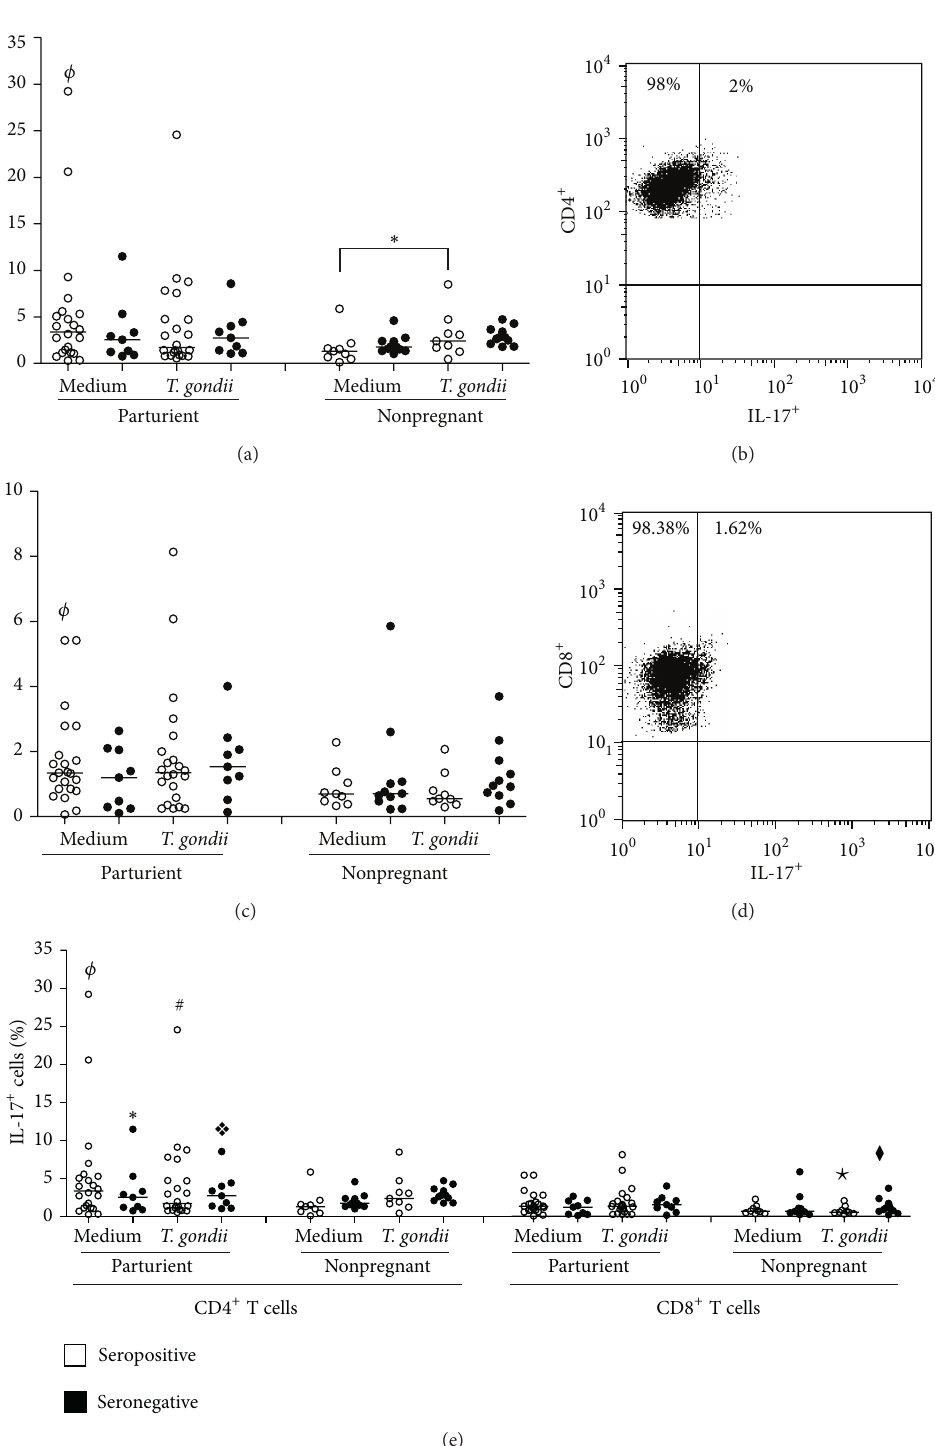
Figure 2: IL-17 + CD4 + T cells and IL-17 + CD8 + T cells from nonpregnant or parturient women. The horizontal line indicates the median, open circles indicate the T. gondii seronegative subjects, and filled circle indicate seropositive subjects. (a) The percentage of CD4 + T cells expressing IL-17. (c) The percentage of CD8 + T cells expressing IL-17. (e) Comparison CD4 + T cells and CD8 + T cell expressing IL-17. One representative dot-plot from each is shown ((b)—seropositive, nonpregnant, and unstimulated × T. gondii stimulated), ((d)—seropositive, parturient, unstimulated × seropositive, nonpregnant, and unstimulated). Gated on CD4 + and CD8 + T cells. The horizontal line indicates the median, bars indicate the 25% and 75% percentiles, and vertical lines indicate the 10% and 90% percentiles. ( ∗ 𝑃 < 0.05 , Wilcoxon test). j ,󳀅, X ,𝜙 Significant differences between PMBCs of seropositive, nonpregnant and parturient women stimulated with T. gondii strain ( 𝑃 < 0.05 , Mann-Whitney